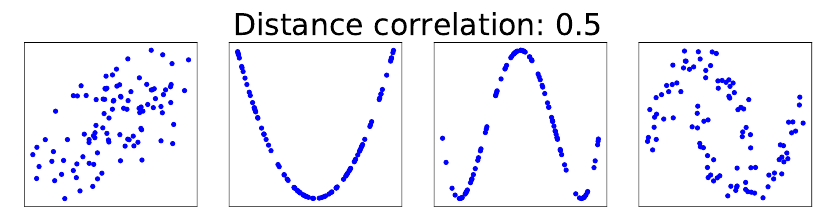
Figure 1. Various dependence types with the same distance correlation of